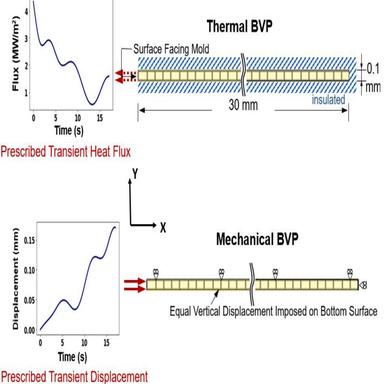
Thermal and mechanical BVPs with random input profiles.